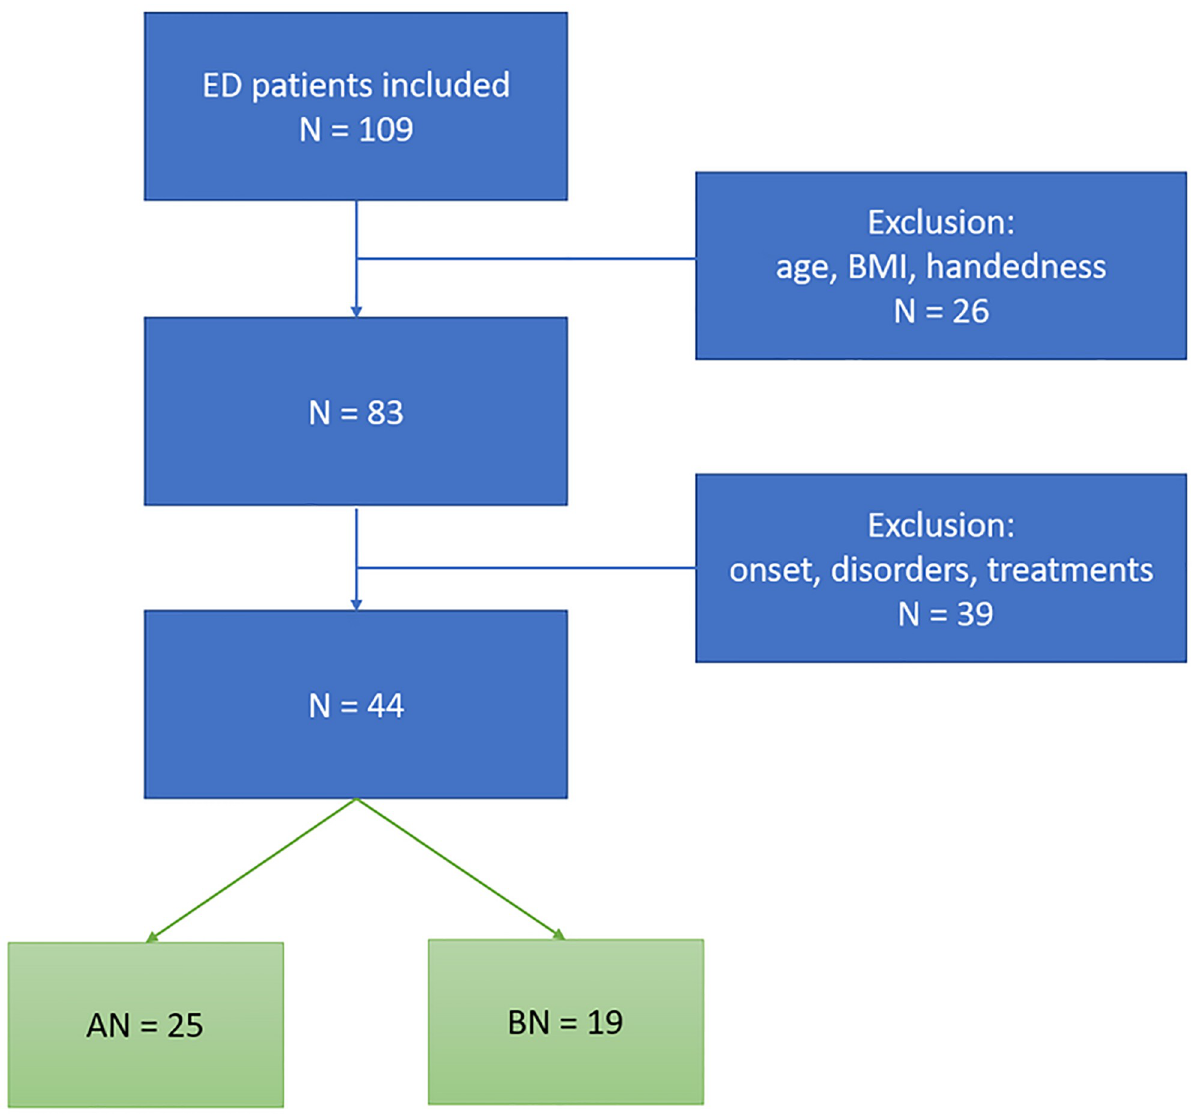
Fig 1. Recruitment